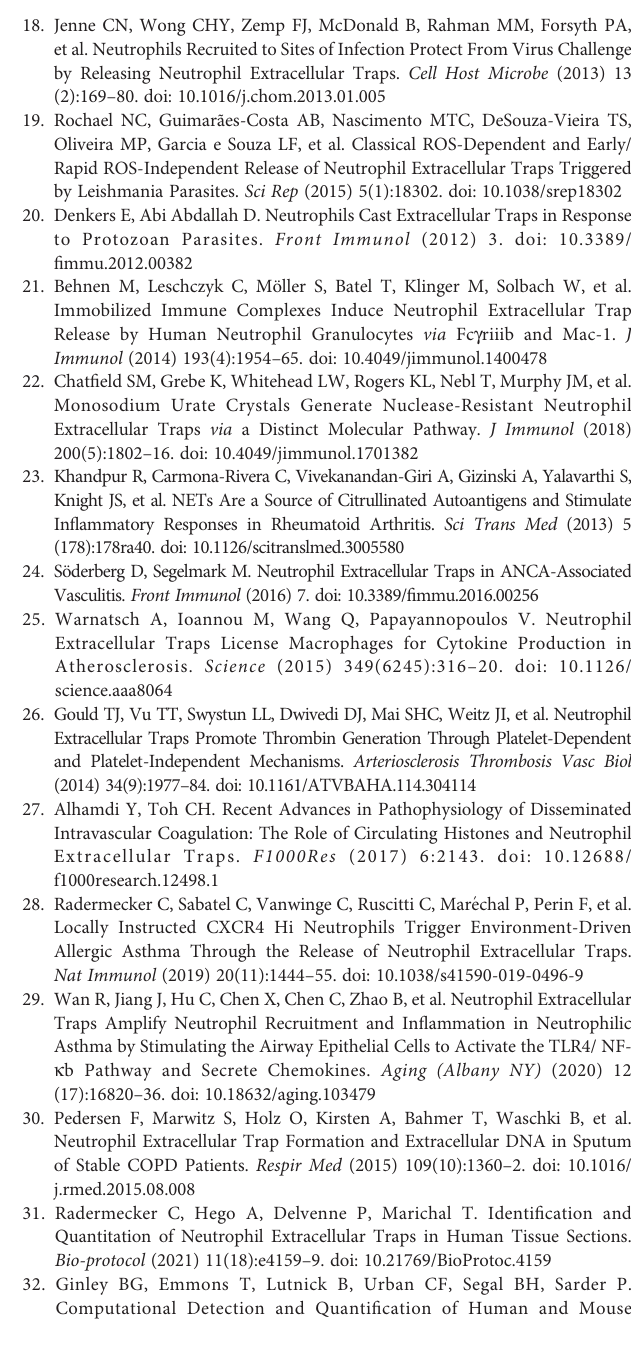
Supplementary Figure 1 | Disease severity correlates with BALF neutrophil percentage. Correlation of disease severity (Weighted clinical score [WCS]) with BALF neutrophil percentage (%). The correlation analysis used was non-parametric (Spearman ’ s correlation) performed on healthy control and asthmatic horses pooled into a single group. *** , P <0.001. Supplementary Figure 2 | Disease severity score and BALF neutrophil percentage are predictive for severe asthma in horses. (A) ROC curve of disease severity and BALF neutrophil percentage for moderate equine asthma. (B) ROC curve of disease severity and BALF neutrophil percentage for severe equine asthma. AUC, Area Under the